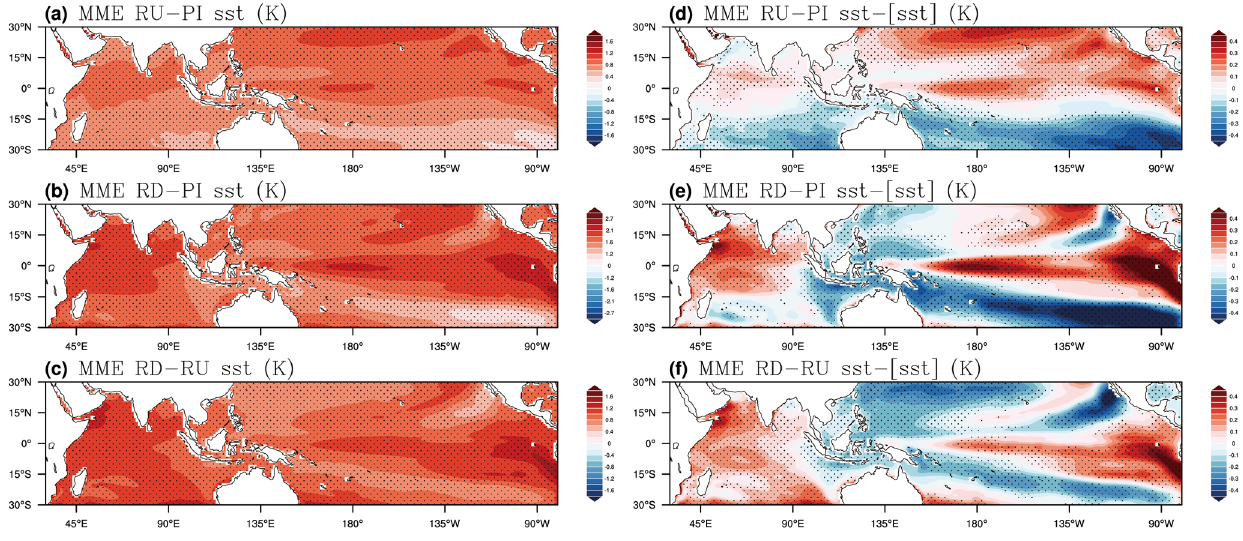
Fig. 9 The responses of SST (unit: K) in the CO 2 ramp-up and ramp-down experiments. a , b The SST anomalies during the RU ( a ) and RD ( b ) periods compared to PI, respectively. c The difference between the RU and RD periods. The right panel ( d – f ) is the same as the left panel, but with the tropical mean SST removed. The black dots denote the region in which at least 70% of models agree on the sign of the MME.